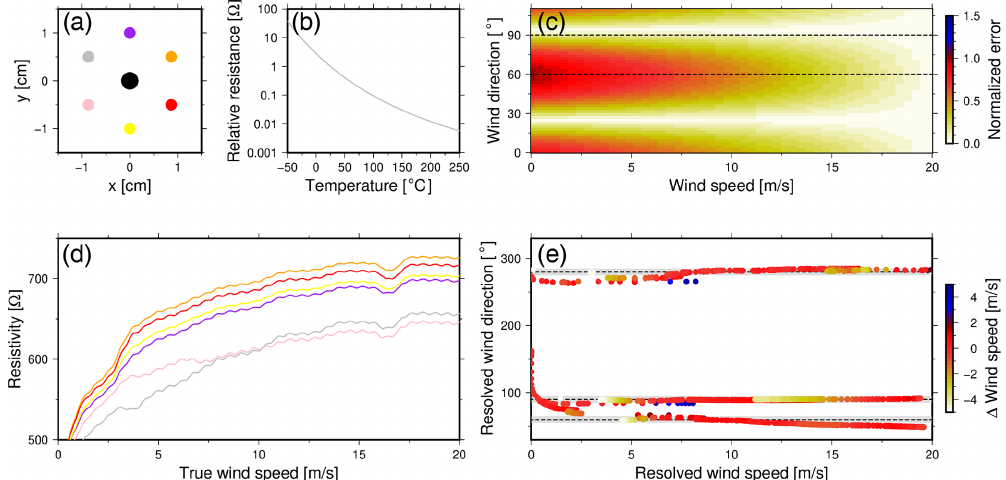
Figure 6. Analyses of the anemometer. Panel (a) shows the top view of the sensor design, with the central heating element. Panel (b) indicates the resistivity of the thermistors over temperature. The geometric sensitivity for the anemometer is shown in panel (c) . The thermistors’ measured resistance for calibration setup 2 (90 ◦ ), for which the colors are in agreement with the sensor design (a) , are shown in panel (d) . Panel (e) indicates the resolved wind direction and wind speed compared with the actual direction (dotted lines) and correct wind speed of setups 1 (270 ◦ ), 2 (90 ◦ ), and 3 (60 ◦ ). The gray shaded area indicates the ± 5 ◦ accuracy